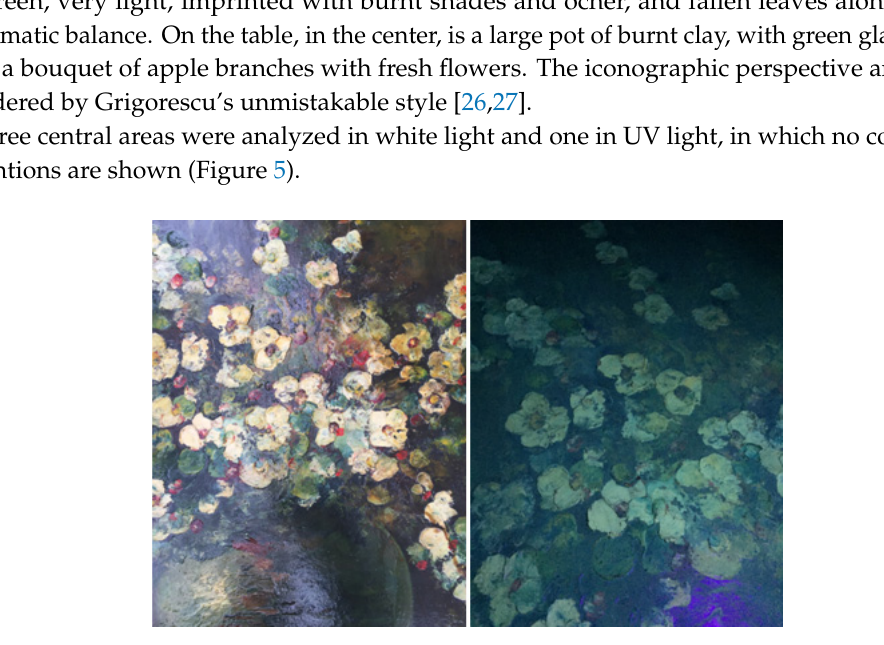
Figure 5. Analysis in white light (left) and UV (right) of two central areas of painting, which demonstrates the lack of falsification interventions.